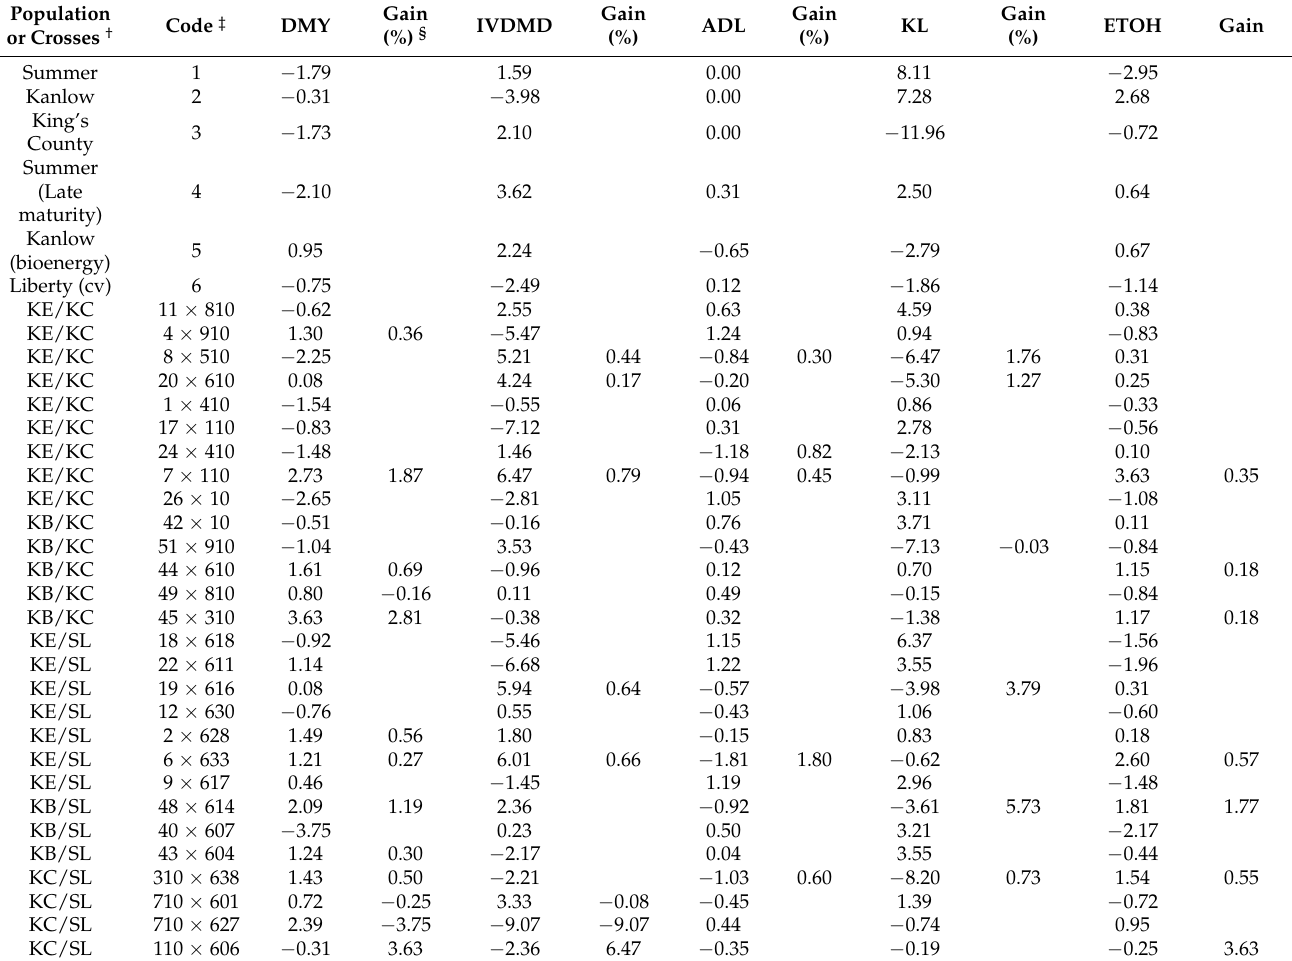
Table 3. Specific combining ability effects (BLUP) for the switchgrass populations and their crosses along with % gain of certain crosses relative to the breeding values of the best